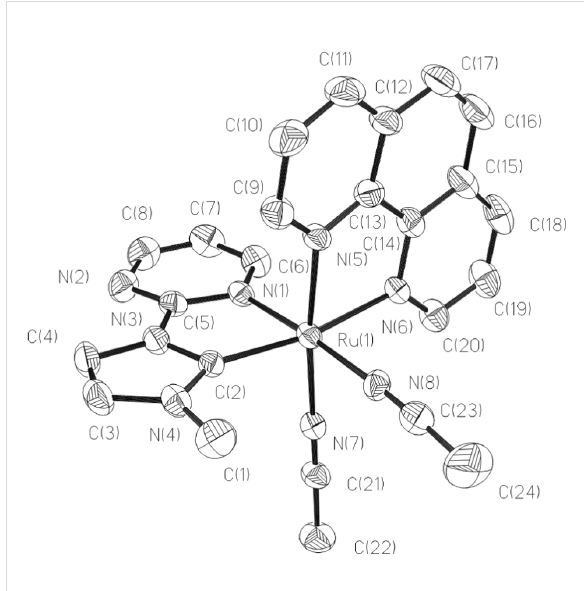
Figure 5: Structural view of 5 showing 30% thermal ellipsoids. All hydrogen atoms and PF 6 − were omitted for clarity. Selected bond lengths (Å) and angles (deg): Ru(1)–C(2) 2.007(5), Ru(1)–N(8) 2.022(4) Ru(1)–N(7) 2.049(4), Ru(1)–N(5) 2.063(4), Ru(1)–N(1) 2.077(4), Ru(1)–N(6) 2.126(4), C(2)–Ru(1)–N(8) 99.06(18), C(2)–Ru(1)–N(7) 91.10(17), N(8)–Ru(1)–N(7) 87.76(16), C(2)–Ru(1)–N(5) 95.03(17), N(8)–Ru(1)–N(5) 90.05(16), N(7)–Ru(1)–N(5) 173.74(16). Symmetry code: #1 x, − y+3/2,